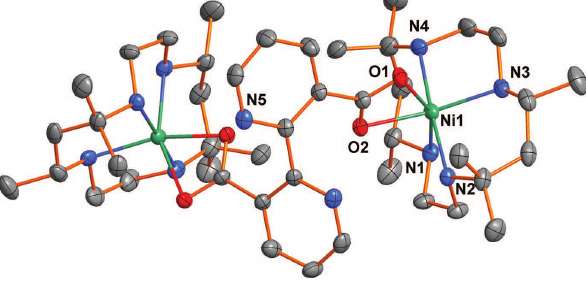
Table 1: Data collection and handling.